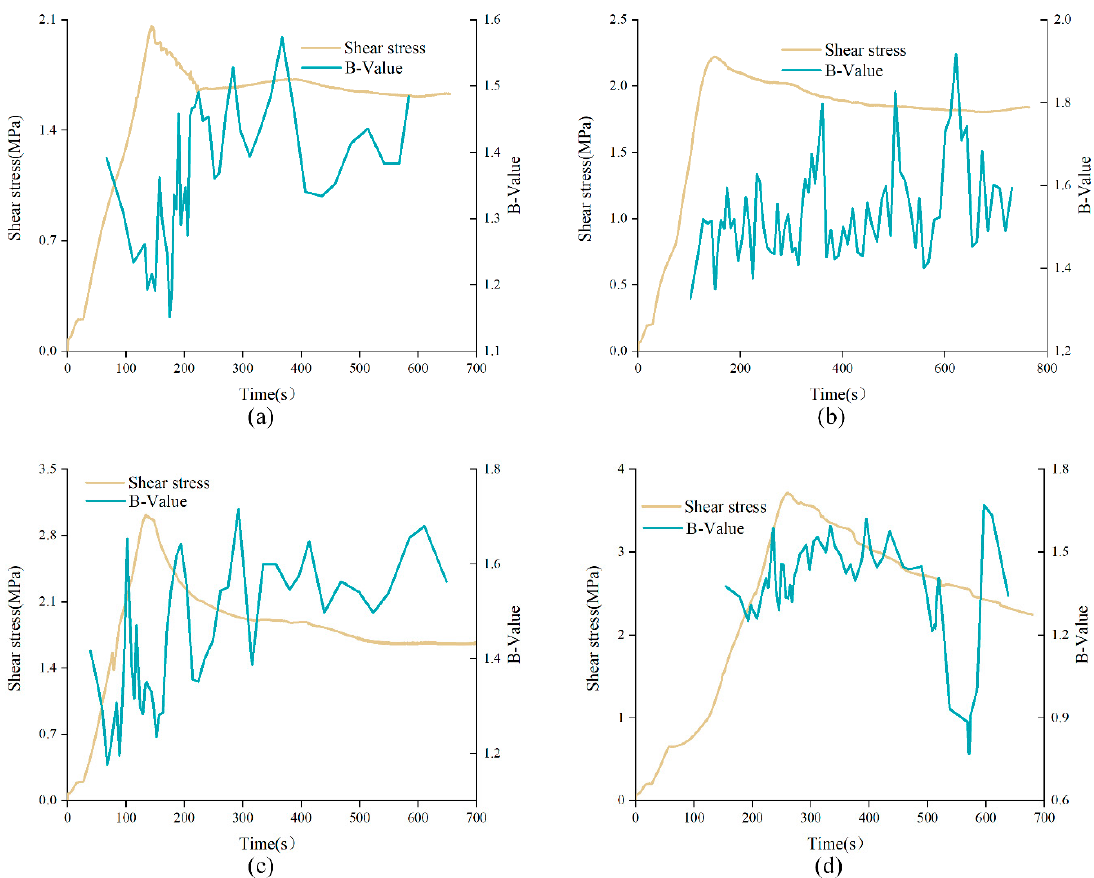
Figure 13. b -value curves of anchored structural planes with different JRC under shearing: ( a ) DS- 02-60-2, ( b ) DS-68-60-2, ( c ) DS-1214-60-2, and ( d ) DS-1820-60-2 (specimen ID: DS-ab- α - σ , where DS represents direct shear experiment, ab represents the range of JRC, α means the anchorage angle, and σ means the normal stress).